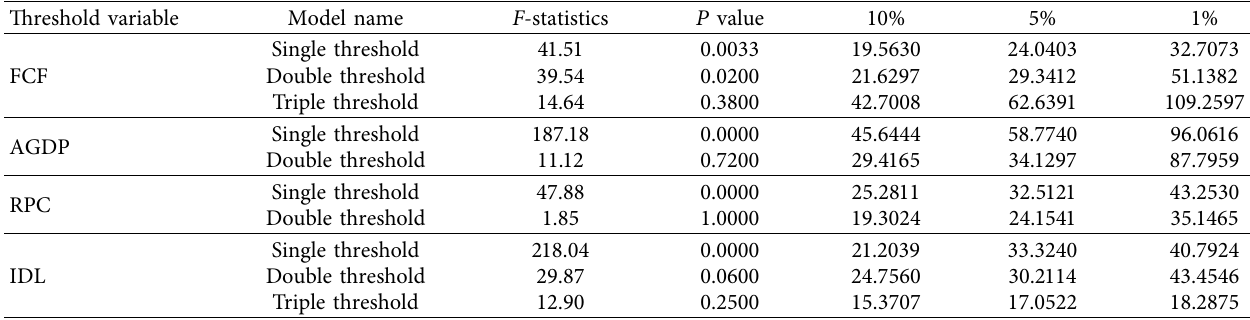
Table 5: Significance test of threshold number.